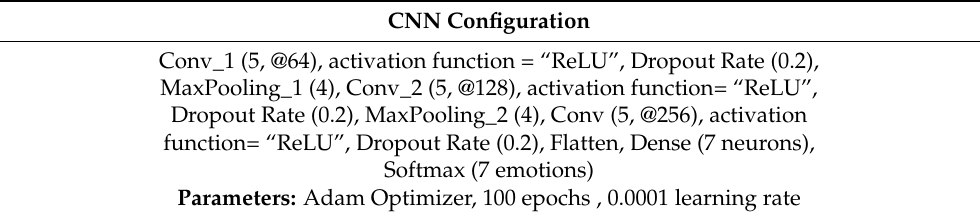
Table 2. Layer structure of the lightweight CNN